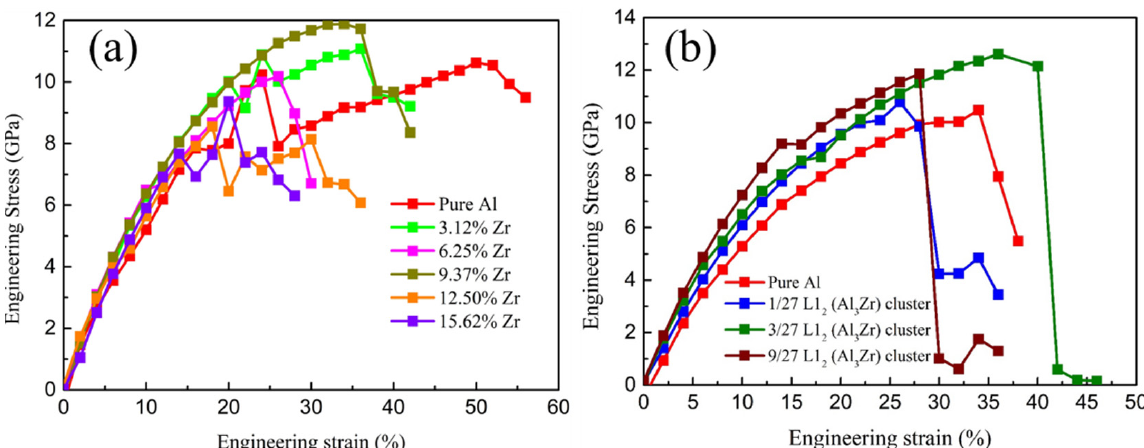
Figure 5. The calculated engineering stress–strain curves in [001] direction. ( a ) The models of the Al solid solution with varied compositions of the solute atom Zr and ( b ) Al supercell models with the chemical short ‐ range ordering clusters L1 2 ‐ Al 3 Zr. Table 4. The calculated ideal tensile strength in the [001] direction for the models of the Al solid solution with varied compositions of the solute atom Zr and Al supercell models with the chemical short ‐ range ordering clusters L1 2 ‐ Al 3 Zr.